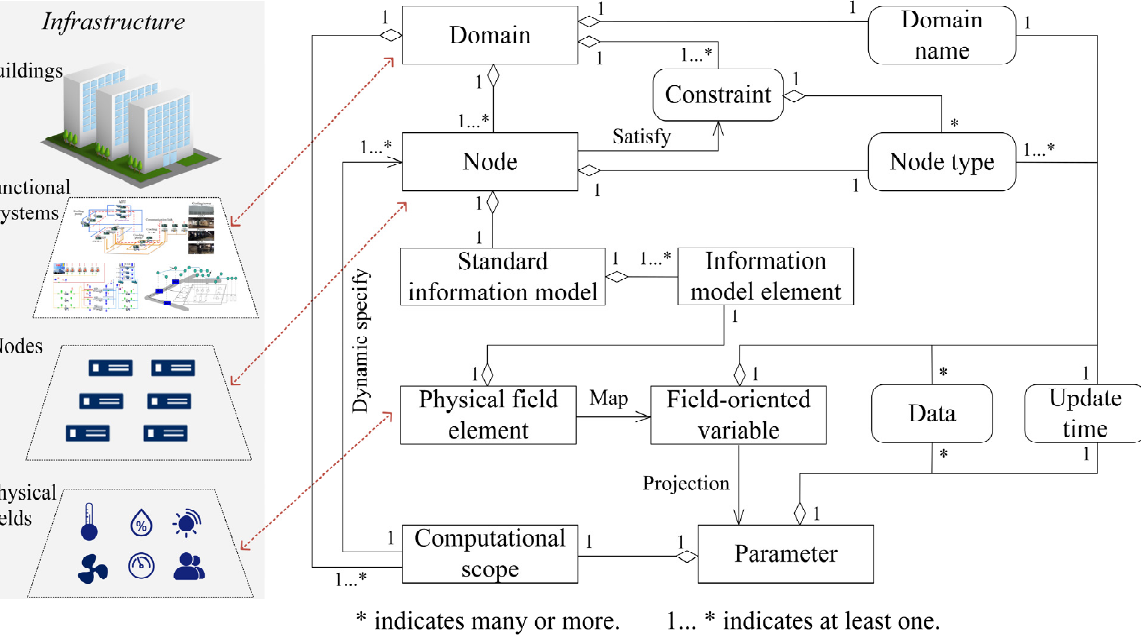
Figure 4. Overview of the SwarmL language model.